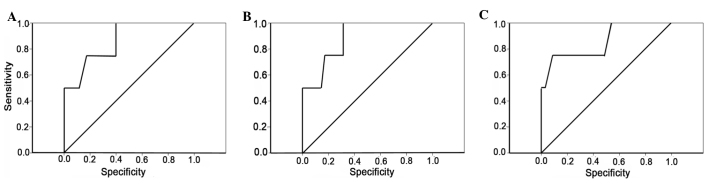
Receiver operating characteristic curves of intraoperative bleeding volume, FVC and FEV1% for late tracheal extubation. The highest diagnostic values and clinical significance were as follows: (A) When the blood loss was >4,100 ml, sensitivity and specificity were 75 and 82.9.2%, respectively; (B) when the preoperative FVC was <77.45, sensitivity and specificity were 100 and 68.6%, respectively. (C) when the preoperative FEV1% was <63.4, sensitivity and specificity were 75 and 91.4%, respectively. FVC, forced vital capacity; FEV1%, forced expiratory volume in 1 sec.